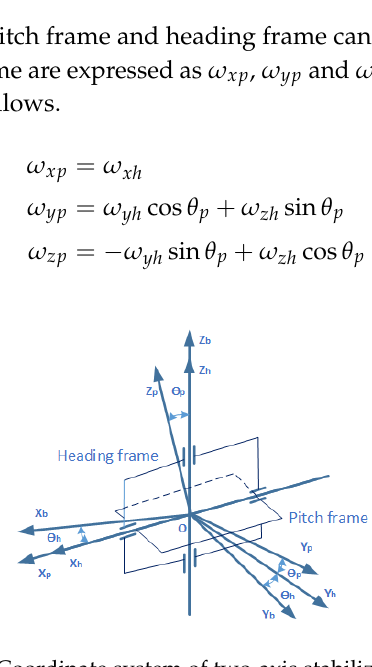
Figure 1. Coordinate system of two-axis stabilized platform